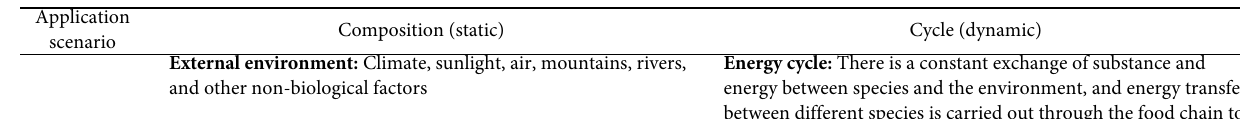
Table 1 Successful applications and potential threats in a smart